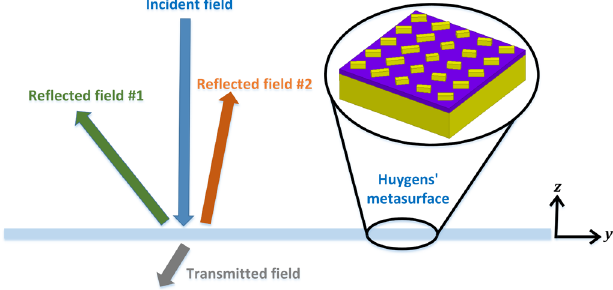
FIG. 1. Field distribution of a metasurface that asymmetrically reflects an incident plane wave into two copolarized plane waves. The incident plane wave is linearly polarized light along the y direction, and it propagates along the − z direction. The two reflected fields of the same polarization are split at − 15 ° and